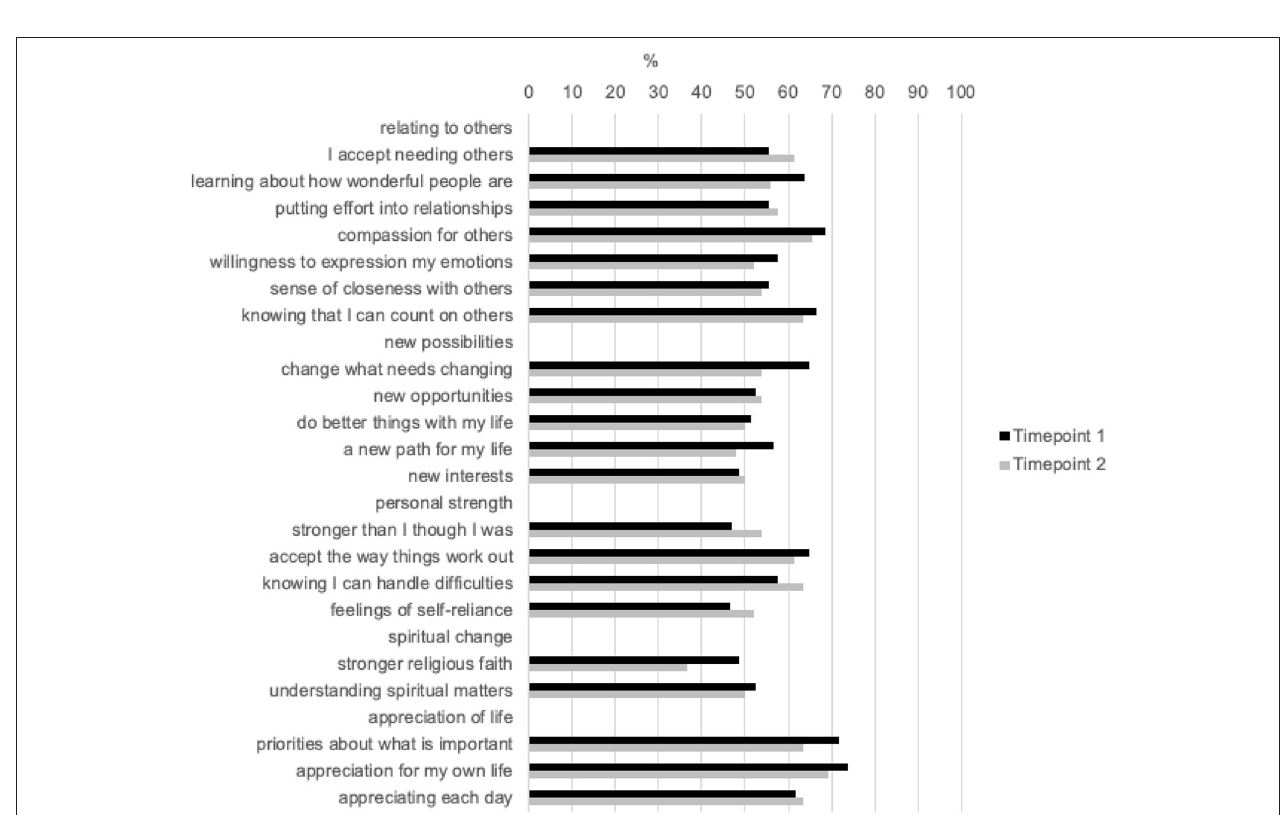
FIGURE 1 | Participants’ endorsement of moderate to very great change in